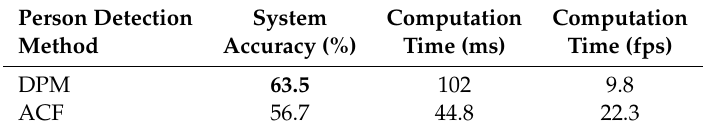
Table 3. Performance Metrics with Unsupervised Learning for DPM and